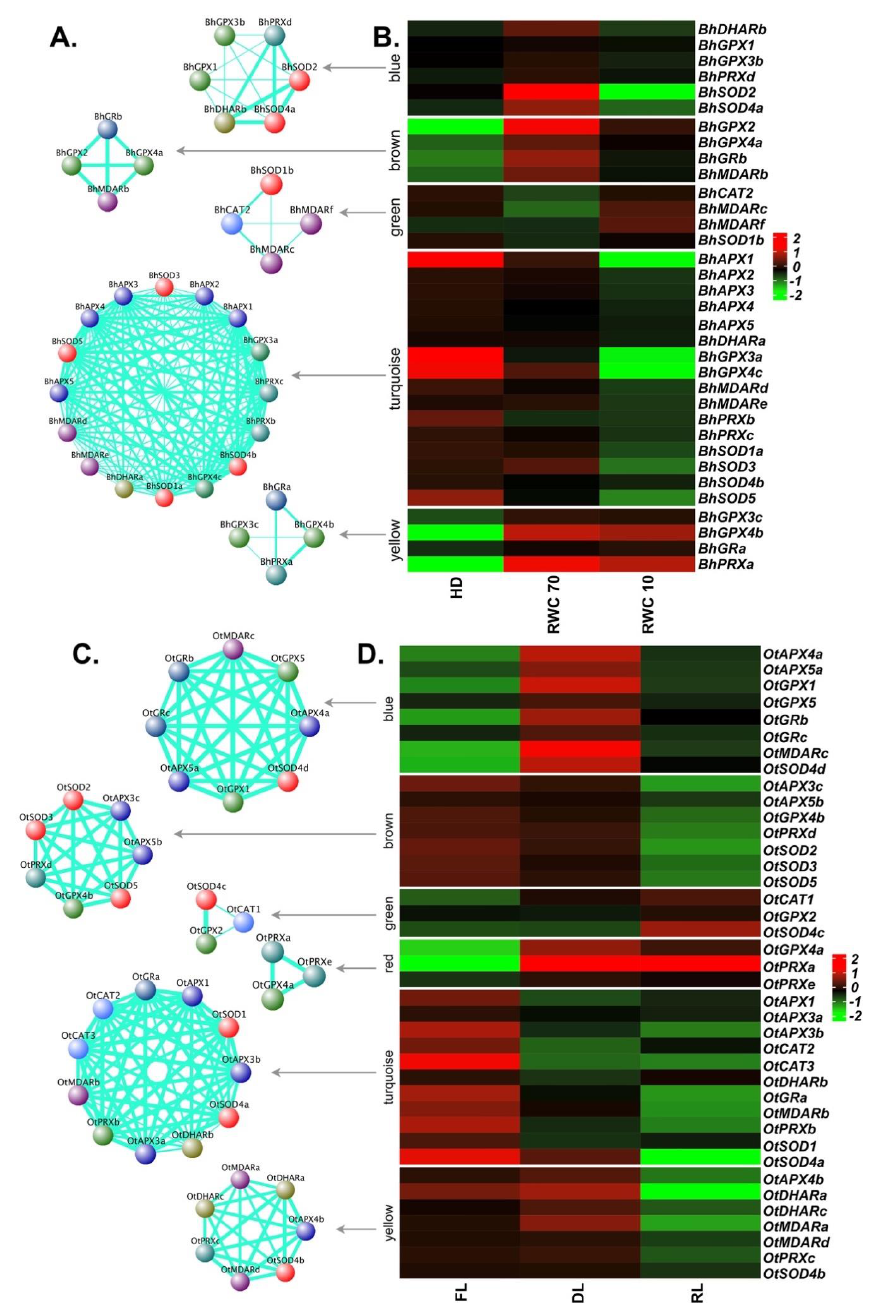
Figure 5. Co-expression network and expression profiles for each module of reactive oxygen species (ROS)-related genes in B. hygrometrica and O. thomaeum. ( A , B ) B. hygrometrica . ( C , D ) O. thomaeum . ( A , C ) Each module is represented as a co-expression network obtained from weighted gene correlation network analysis (WGCNA) analysis. Nodes correspond to a gene and are colored based on the gene family. Thickness of the edges represent the weight. Edges below adjacency threshold of 0.02 and the nodes without edges were removed. ( B , D ) Expression profile for all the genes in the module are plotted as a heatmap. Color scale represents the log 2 transformed and mean centered TMM values. HD: fully hydrated; RWC: relative water content; FL: fresh leaves; DL: desiccated leaves; RL: rehydrated leaves. RWC is calculated as (fresh weight–dry weight) × 100 / (turgid weight–dry